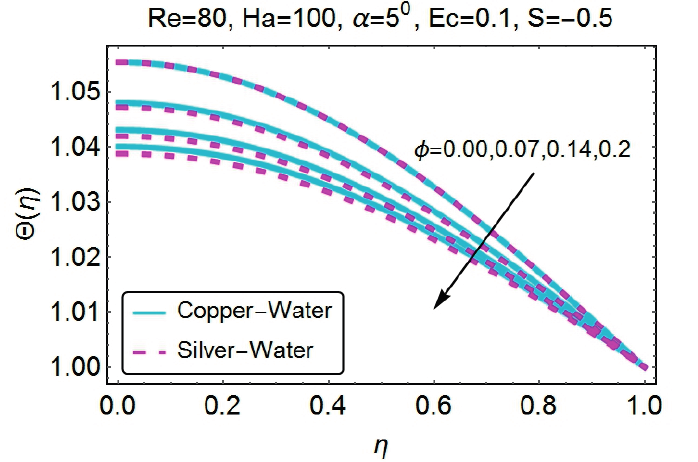
Figure 17. Change in temperature for varying ϕ (divergent channel/shrinking case).